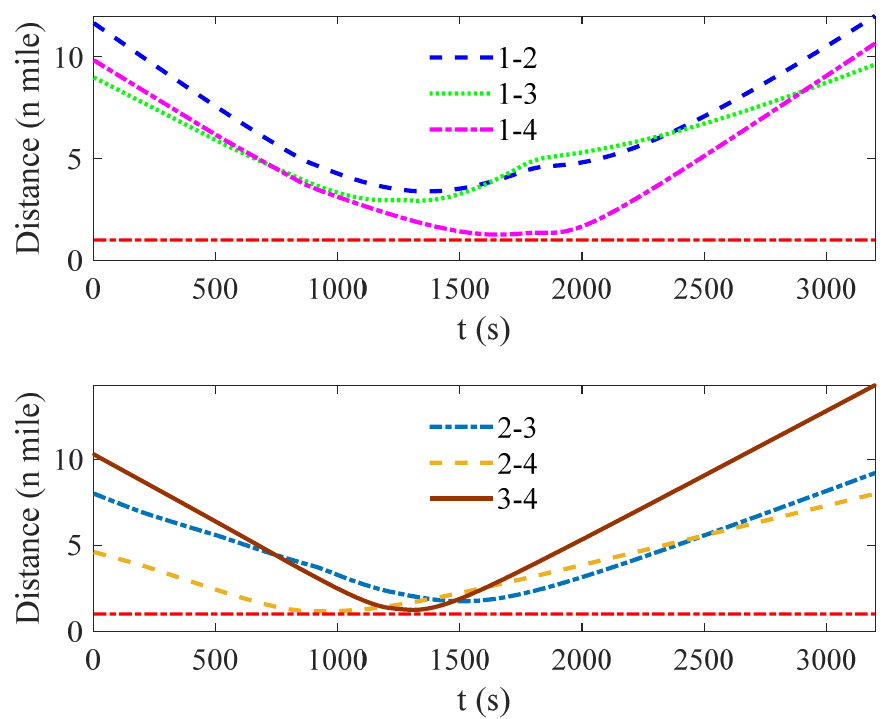
Figure 17. The distance between any two ships in scenario 2.